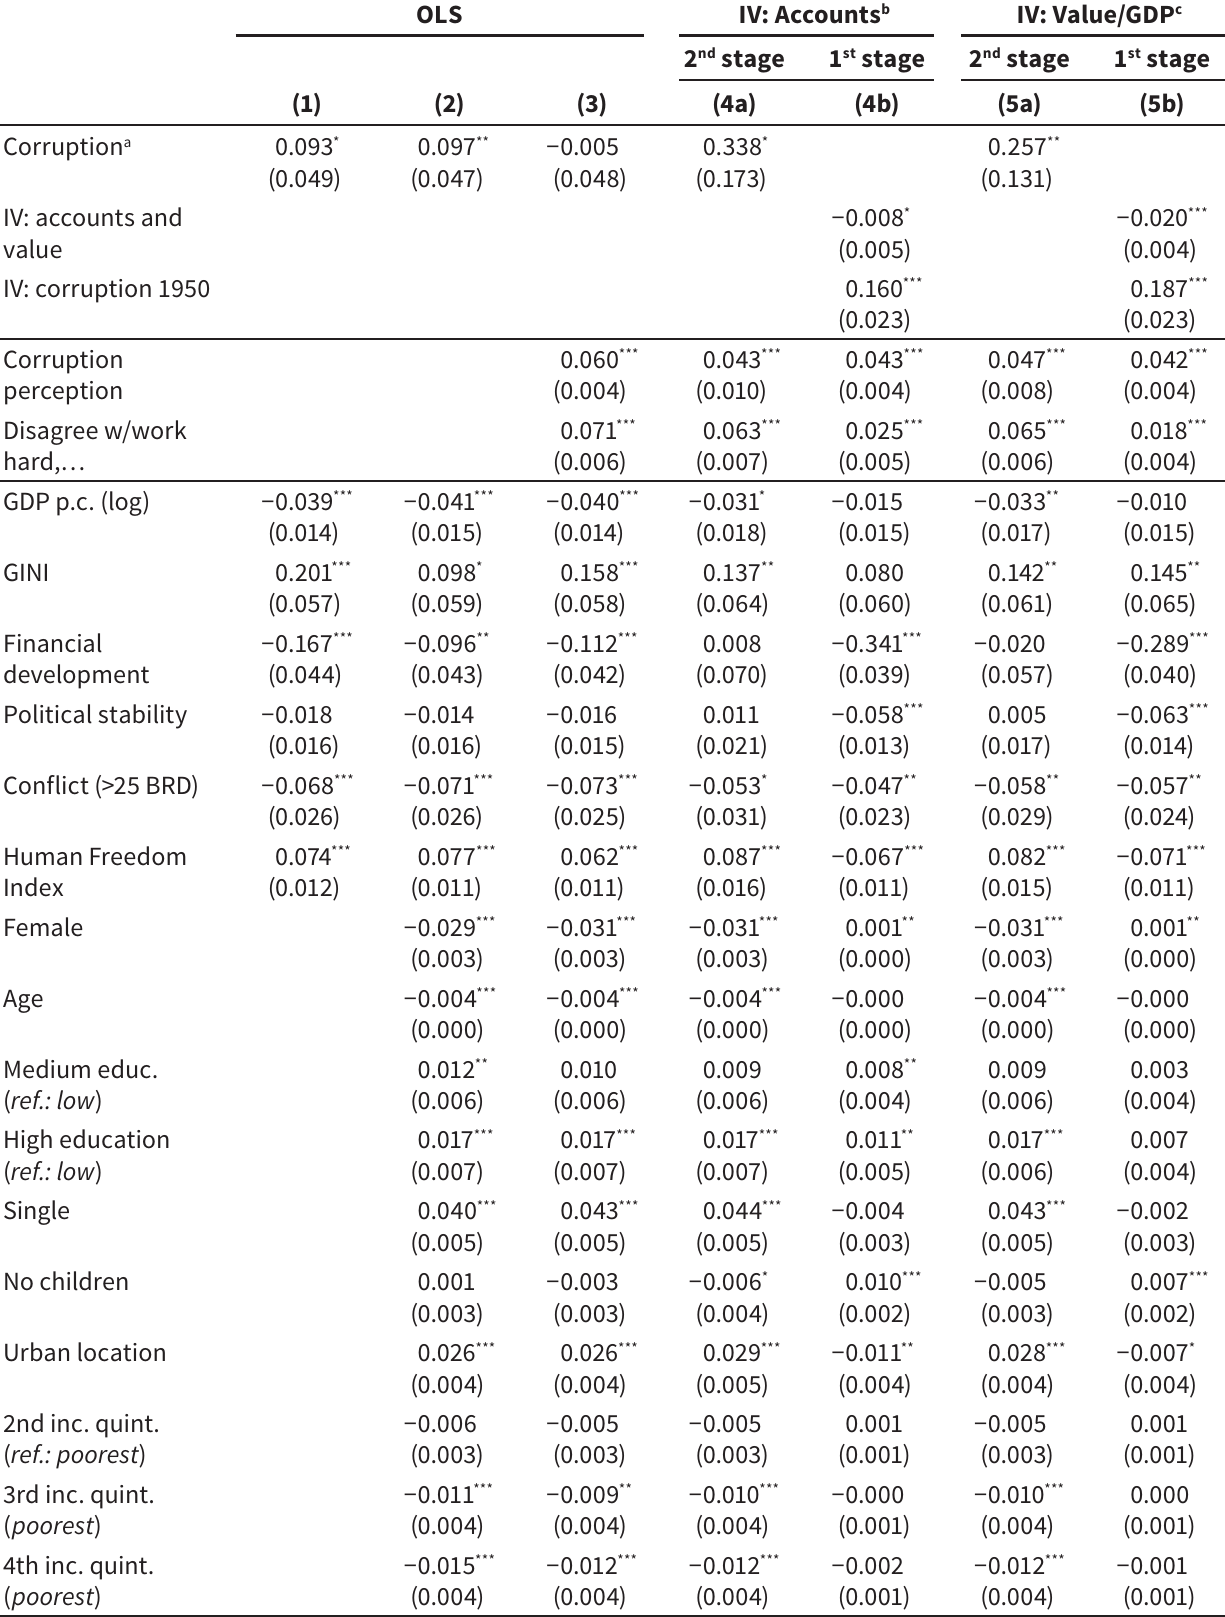
Full regression table for emigration desire (inverse of CPI corruption